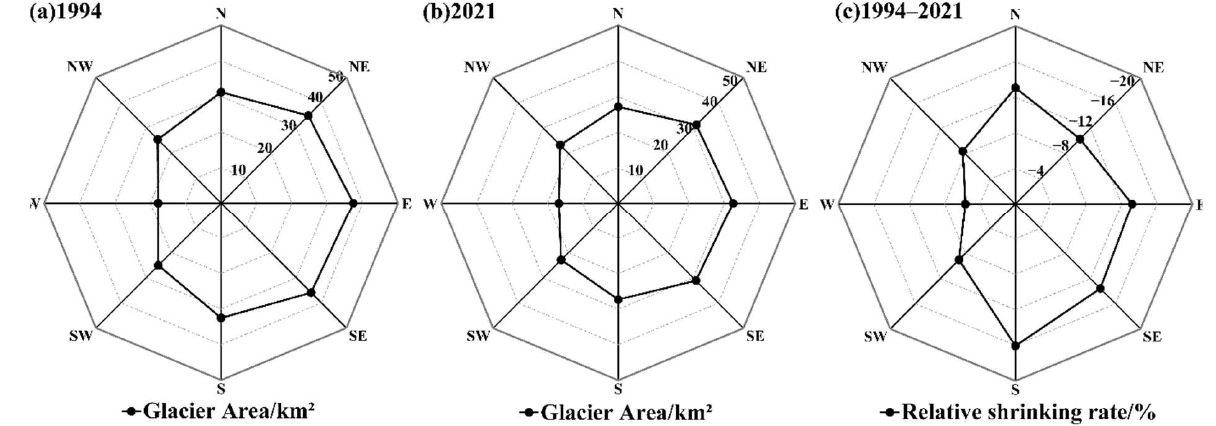
Figure 8. Glacier shrinkage in all aspects of the Gongga Mountains, including the glacier area in 1994 ( a ), in 2021 ( b ), and the glacier shrinking rate from 1994 to 2021 ( c ).